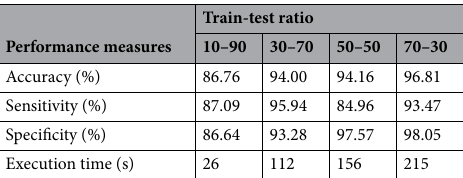
Table 2. Performance measures obtained on 2-layer CNN classifier.